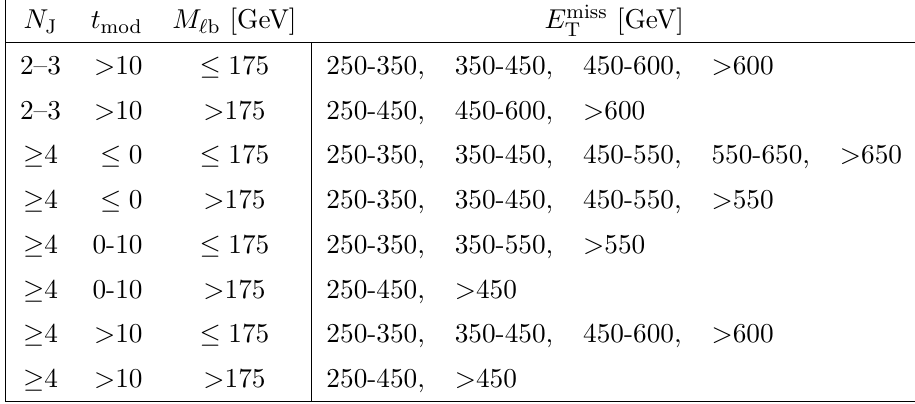
Table 2 . De(cid:12)nitions for the 27 signal regions of the standard selection. At least one b-tagged jet satisfying the medium WP algorithm is required in all search regions. To suppress the W+jets back- ground in signal regions with M ‘ b > 175 GeV, we instead use the more strict tight WP requirement.